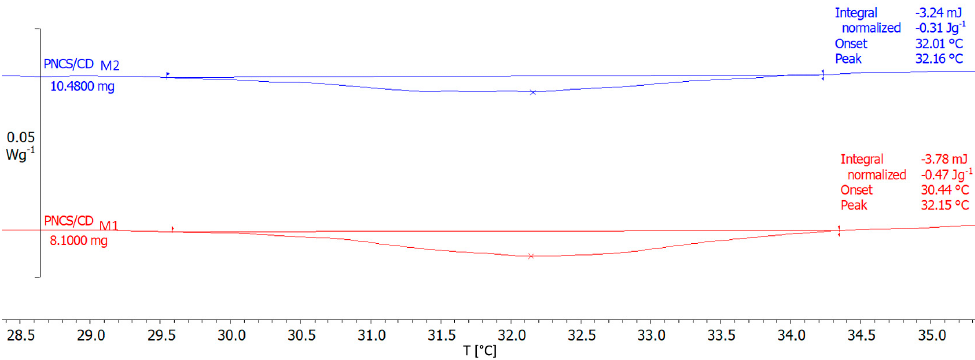
Figure 3. Hydrodynamic PNCS/CD hydrogels particle diameter in the dispersion with the corresponding polydispersity index (PDI) values.